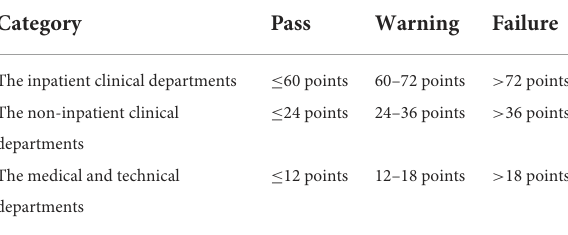
TABLE 3 The hierarchy of annual scorekeeping assessment results for doctors, medical and technical staff.